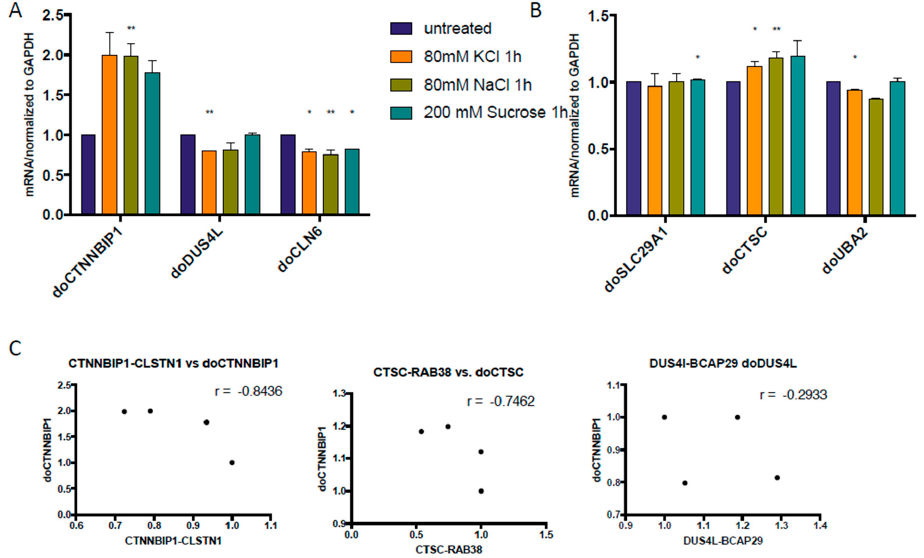
Figure 3. Inverse correlation between DoGs and corresponding cis-SAGe RNAs at 1 h after osmostress. ( a ) DoGs of the 5’ parental genes of CTNNBIP1-CLSTN1 , DUS4L-BCAP29 , and CLN6-CALML were measured; ( b ) DoGs of the 5’ parental genes of SLC29A1-HSP90AB1 , CTSC-RAB38 , and UBA2-WTIP were measured . The levels of various transcripts were normalized to that of GAPDH and further normalized to the untreated samples; ( c ) The levels of the DoGs and their fusion RNAs were plotted in scatter plots. Three examples are shown here. *: p < 0.05, **: p < 0.01. 3.3. Both DoGs and Corresponding cis-SAGe Fusions Are Induced in Response to Prolonged Treatment